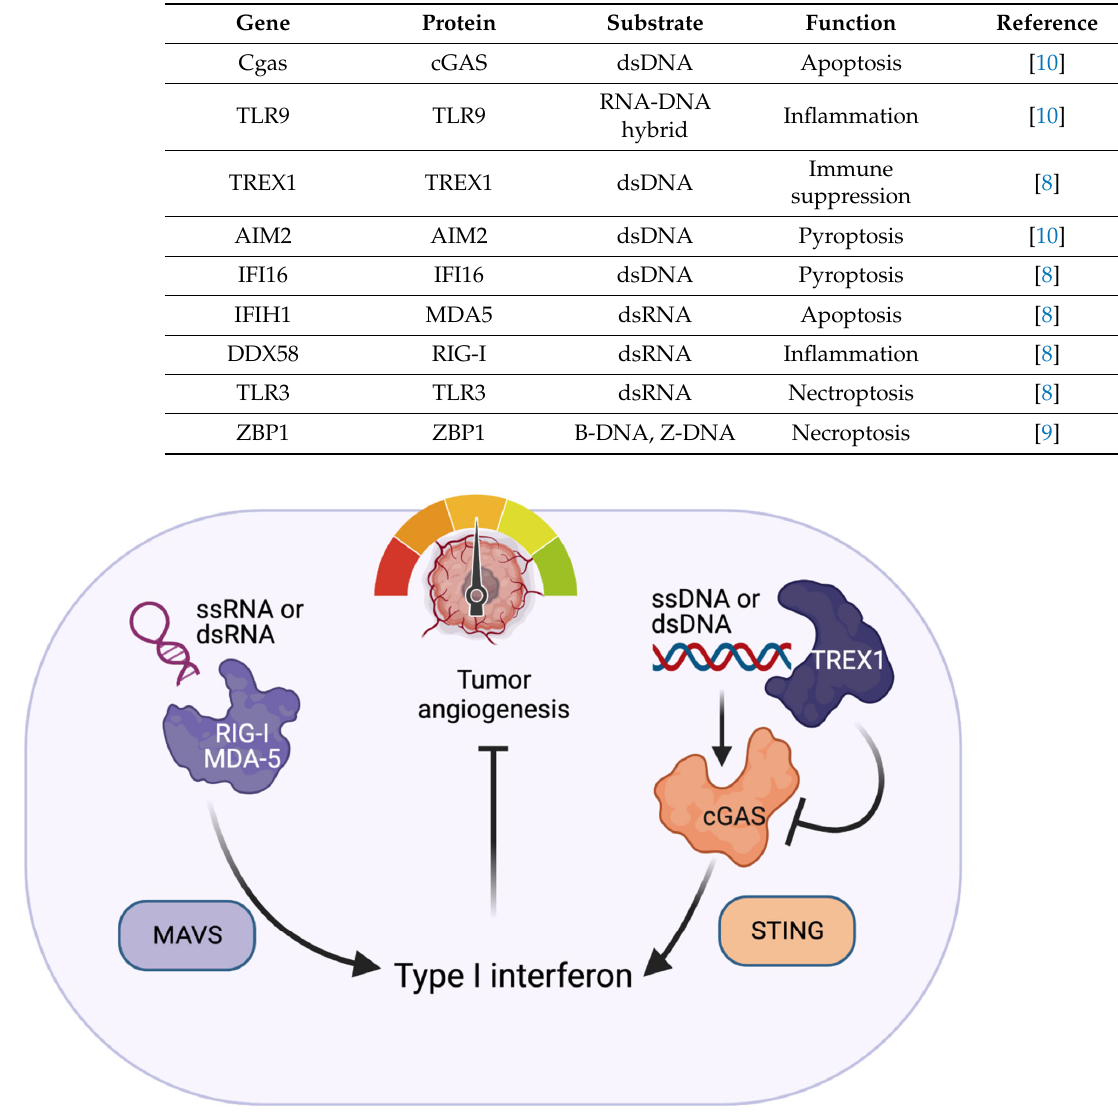
Table 1. Summary of nucleic acid sensor substrates and functions.